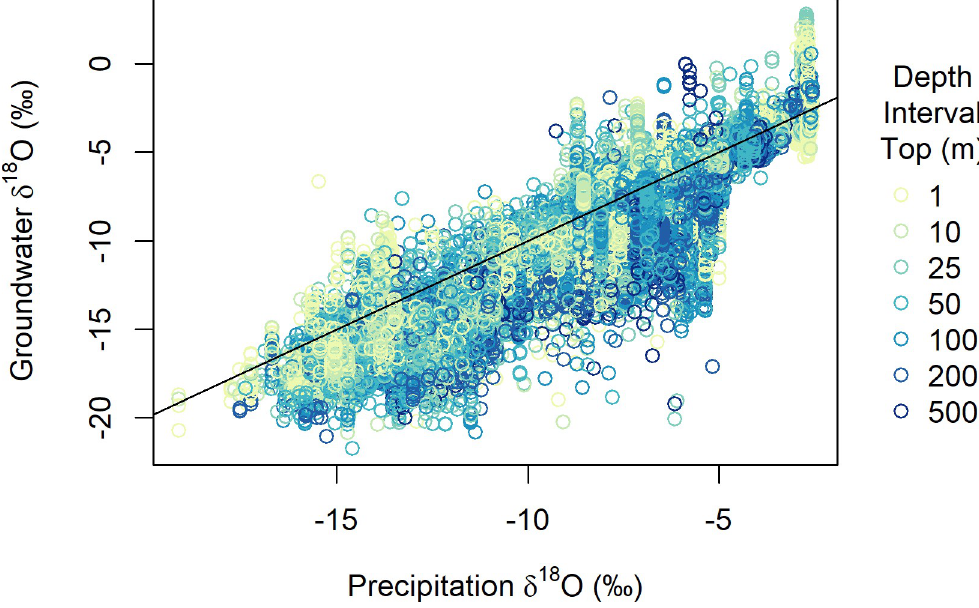
Fig 4. δ 18 O values for GWI database samples and interpolated modern, annual-average precipitation, as a function of well depth. The 1:1 line is shown in black.